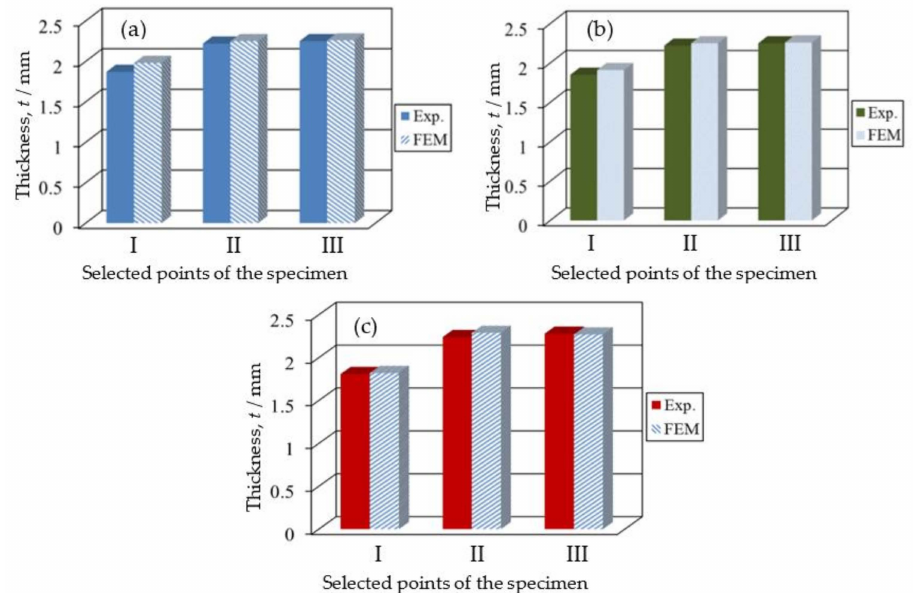
Figure 3. Thickness of the selected points in the tube end obtained in the FEM simulations and experiments. ( a ) α = 10 ◦ ; ( b ) α = 15 ◦ and ( c ) α = 30 ◦ ; α : semi angle of the conical